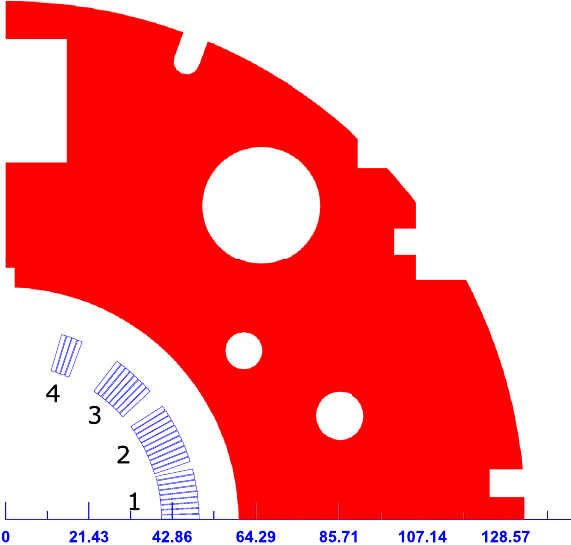
FIG. 2. The cross section of the RHIC main arc dipole magnet. The first quadrant with four coil blocks is shown (Unit: mm).